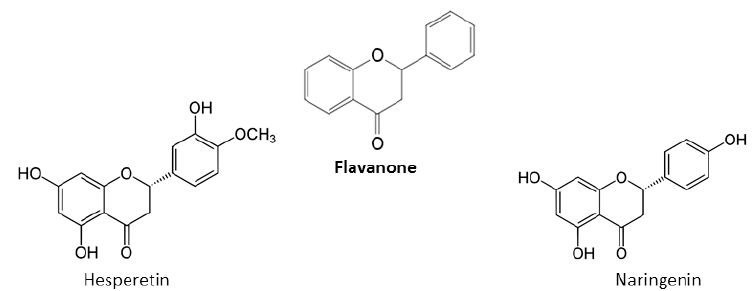
Figure 3. Chemical structures of main flavanones.